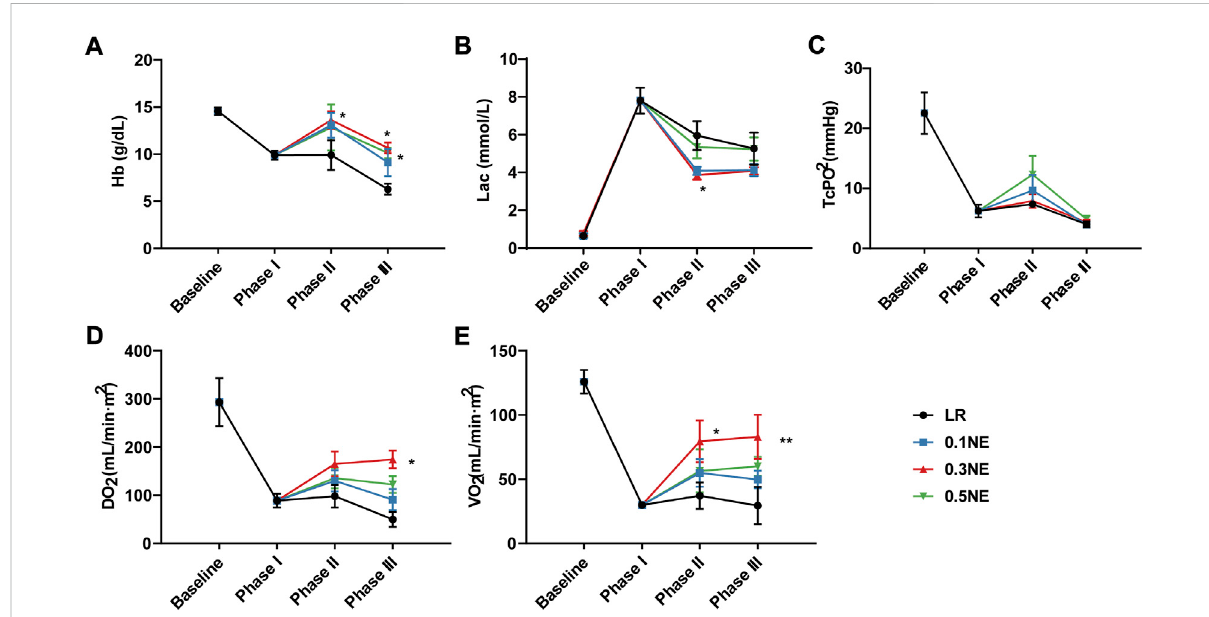
FIGURE 6 The effect of NE on oxygen delivery and consumption following 1 h of hypotensive resuscitation. (A) Hb. (B) blood lactate. (C) TcPO 2 . (D) DO 2 . (E)